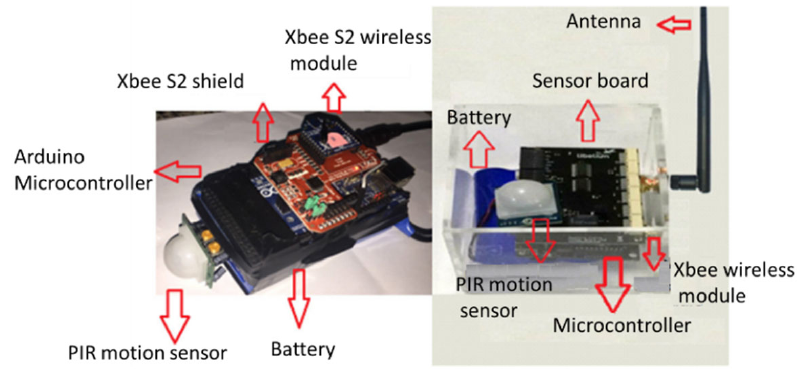
Figure 2. Images of two typical MCU ‐ based wireless sensor nodes [18].